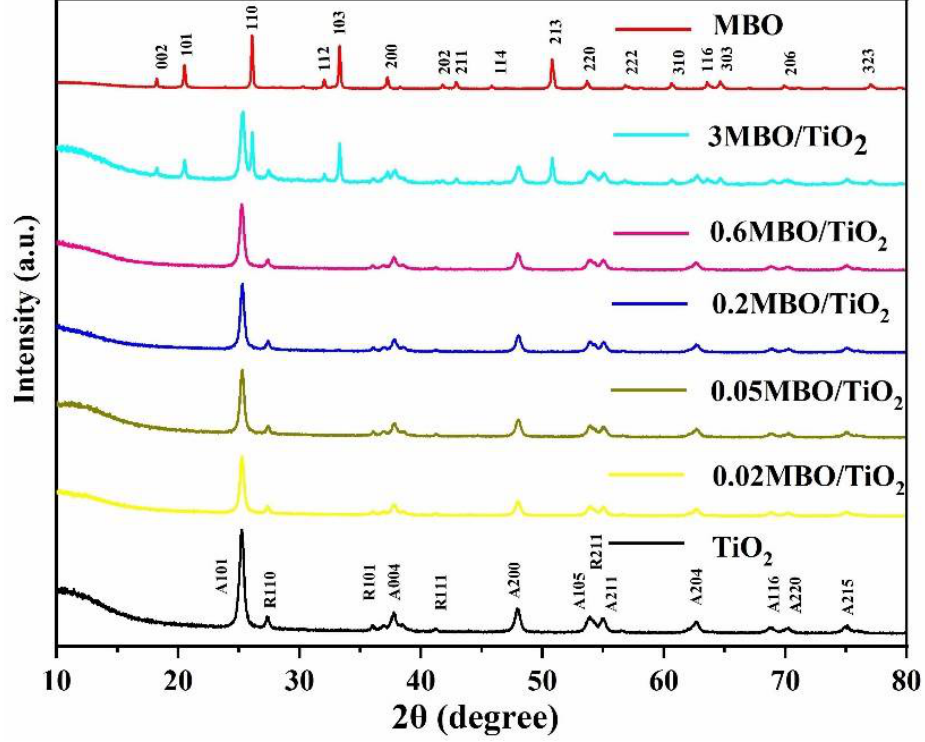
Figure 1. XRD patterns of pure MBO, TiO 2 and the as-prepared MBO/TiO 2 composites with different MBO contents.